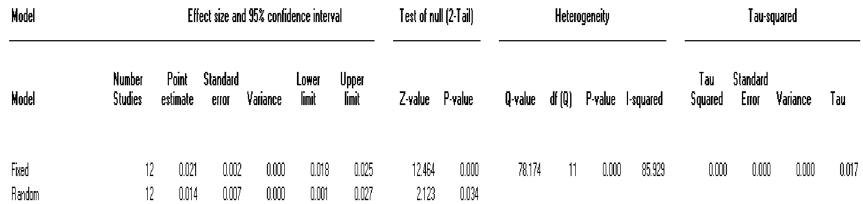
Fig. 7 Results of meta-analysis based on MAE as Hedge’s g and RMSE as Standard